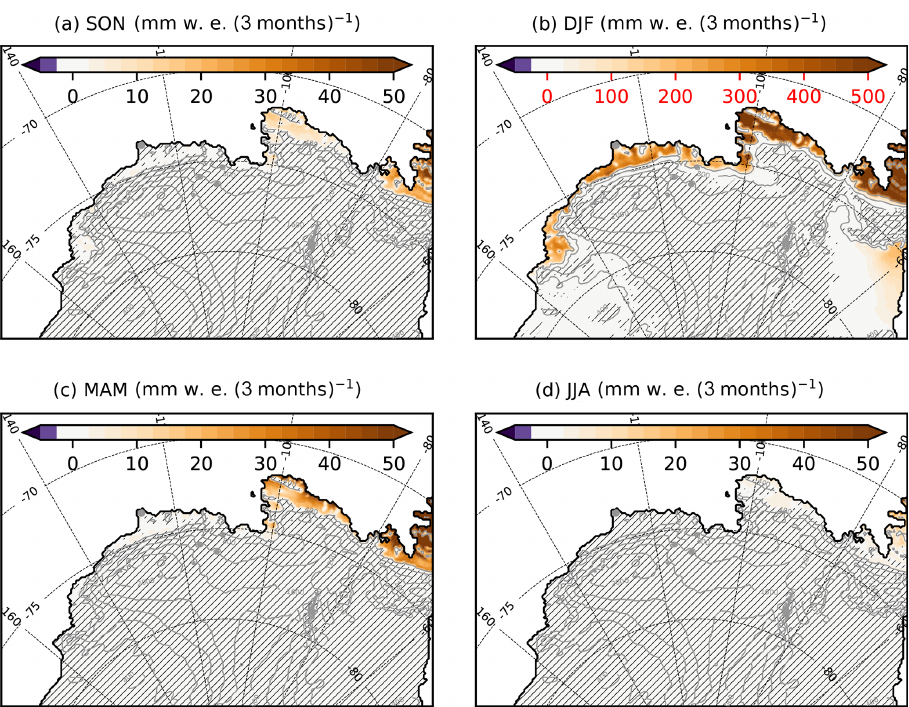
Figure 6. Changes in seasonal mean melt rates (future minus present). The colour-bar labels in panel (b) are shown in red to emphasise the different range compared to the other panels. Black hatching indicates areas where the difference is not statistically significant ( t test on 3-month means with a p value of 0.05). The ice-sheet topography is shown in grey (contours every 400m).